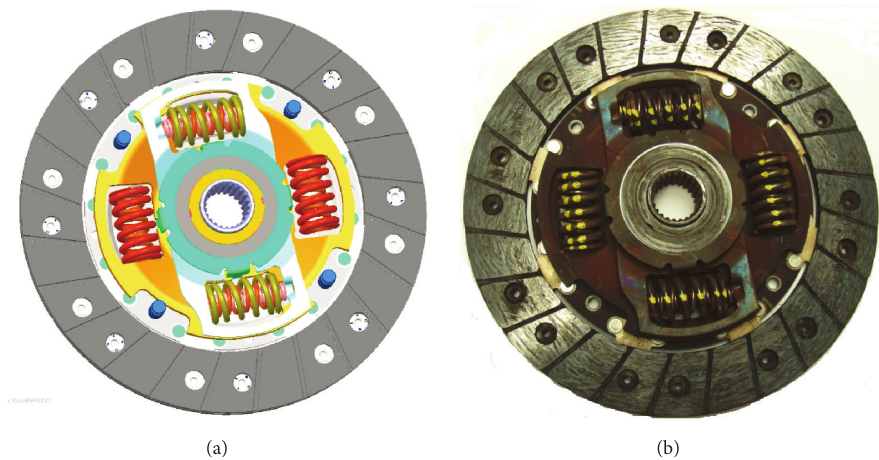
Figure 31: A three-stage stiffness clutch damper adopted in the model: (a) 3D model, (b) physical